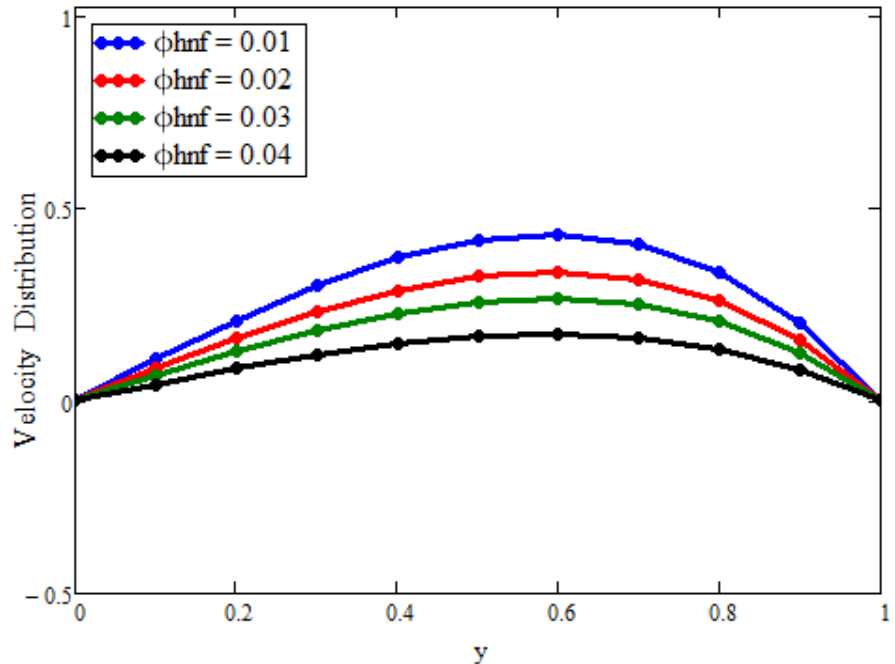
Figure 7. Velocity distribution against y due to φ hnf , when t = 40 , Pr = 6.2 , Gr = 15, M = 2, 𝛼 = 𝛽 = 𝛾 = 0.5 .